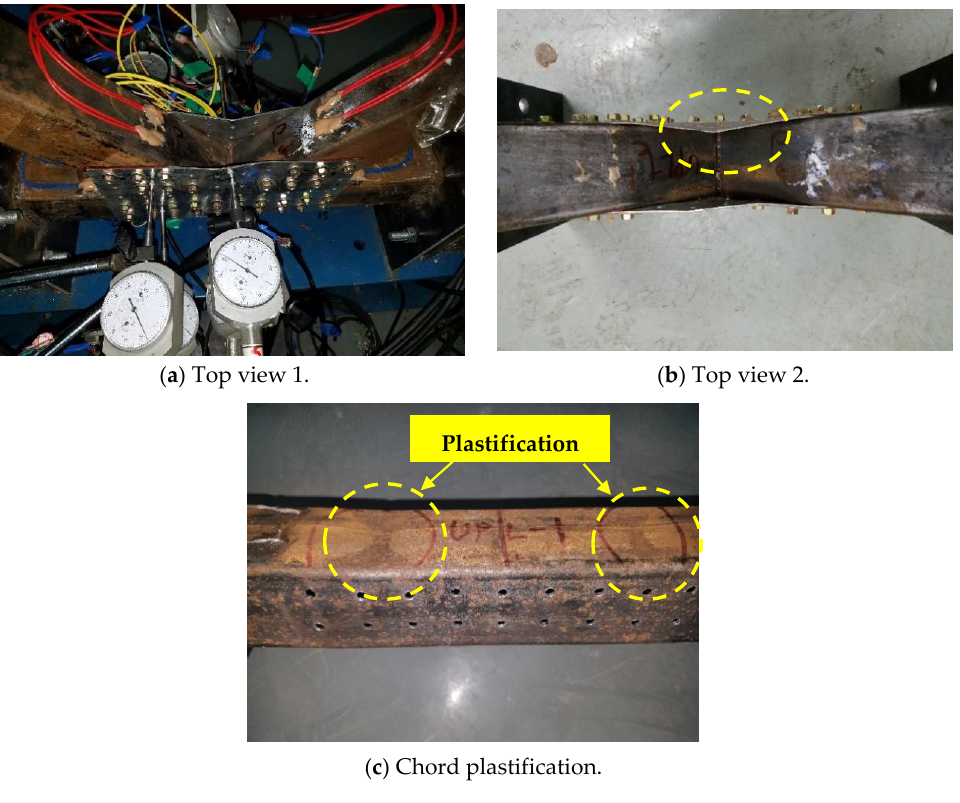
Figure 12. Deformation of the specimen UPL-1.